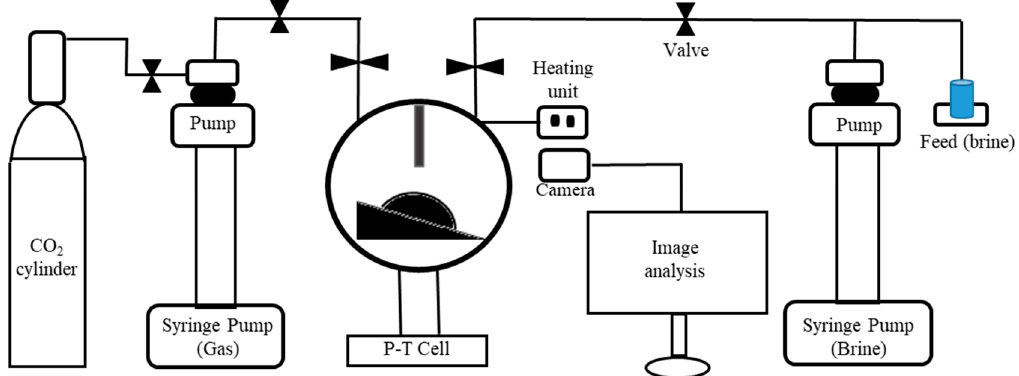
Figure 2. The experimental setup for the contact angle measurement (modified from